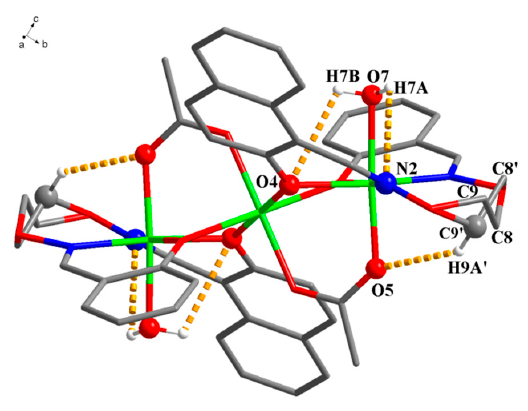
Figure 4. The intramolecular hydrogen bonds of the Cu II complex. Table 4. Intramolecular hydrogen bonding data [Å,°] of the Cu II complex.